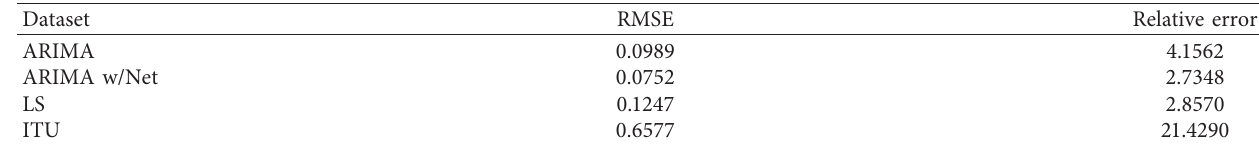
Table 12: ARIMA, ARIMA with neural network, LS, and ITU errors for “data3.”